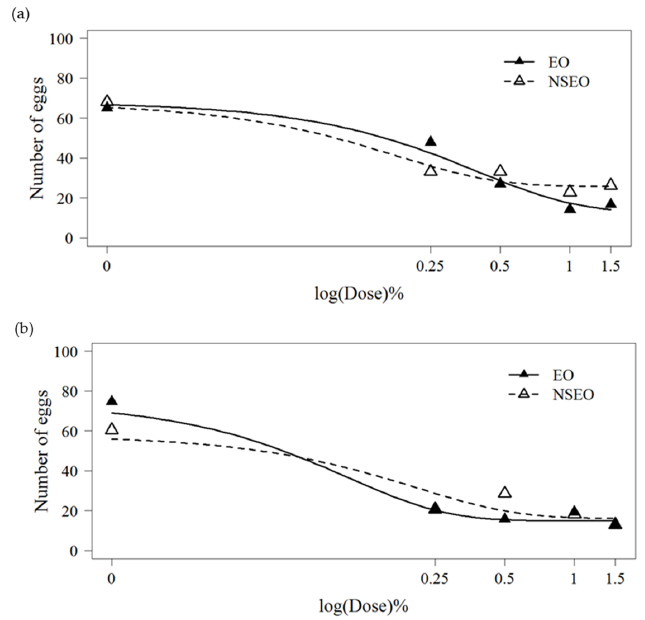
Figure 2. Mean number of B. tabaci eggs on bean leaves treated with different concentrations of the essential oil of Z. rhoifolium fruits in free (EO) and nanoencapsulated (NSEO) forms in the free-choice test ( a ) and the no-choice test ( b ). Dose–response curves were fitted using the 4-parameter generalized adjusted according to log-logistic model for a binomial response data. Table 5. Mortality of 2nd-instar nymphs of B. tabaci after treatment of bean leaves with essential oil of Z. rhoifolium fruits in the free (EO) and nanoencapsulated (NSEO) form in three experiments in a screenhouse.